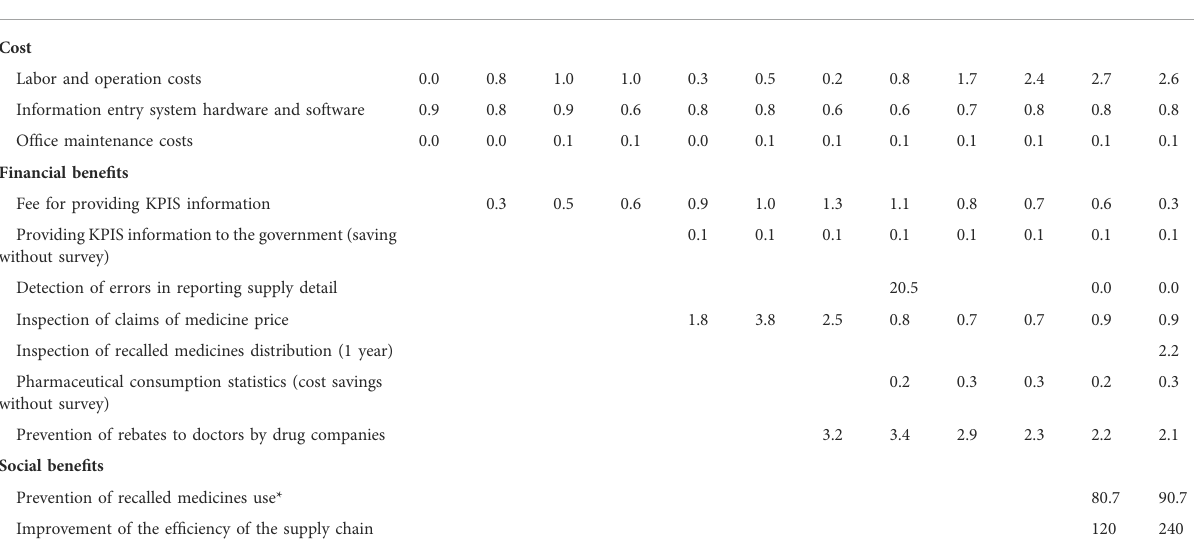
TABLE 2 Twelve-year costs and savings from the implementation of KPIS program (million